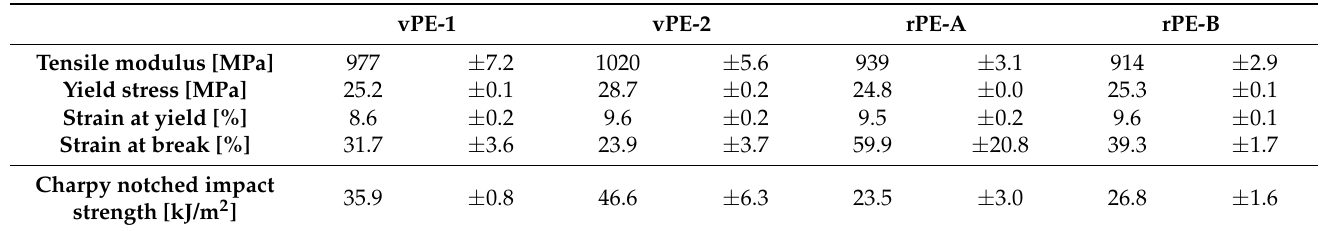
Table 2. Tensile and Charpy notched impact properties (average values and sample standard